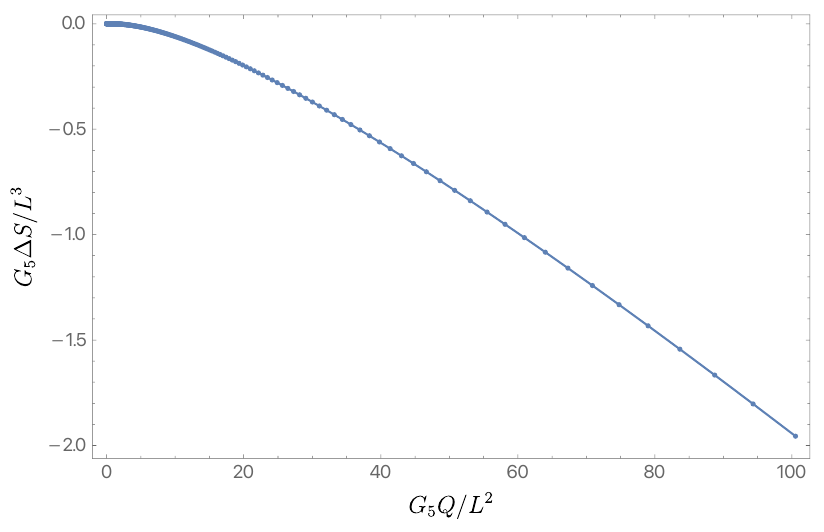
Figure 4 . The difference in entropy between the new near horizon geometries and RN AdS, as a function of